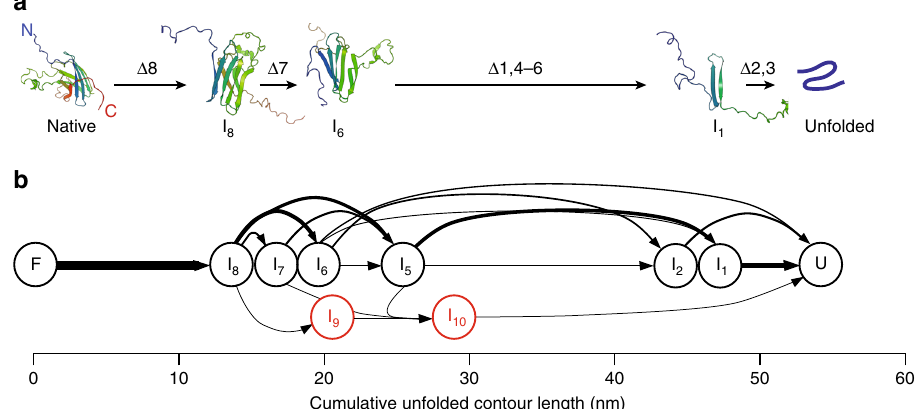
Fig. 5 Simulations of mechanical unfolding of SOD1. a Structural snapshots from a steered molecular dynamics simulation depicting intermediates during SOD1 unfolding. b Transition map from the simulations ( N = 26) showing all pairwise transitions between states; arrow width represents the relative transition probability. The intermediates observed computationally match the structures proposed for those observed experimentally, except for states I 9 ( β 3 – 7 folded) and I 10 ( β 3 – 6 folded), which were not consistent with the